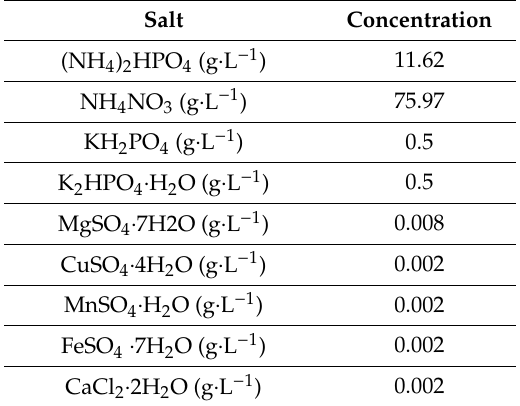
Table 1. Mineral salt medium for bacteria (MSMB)